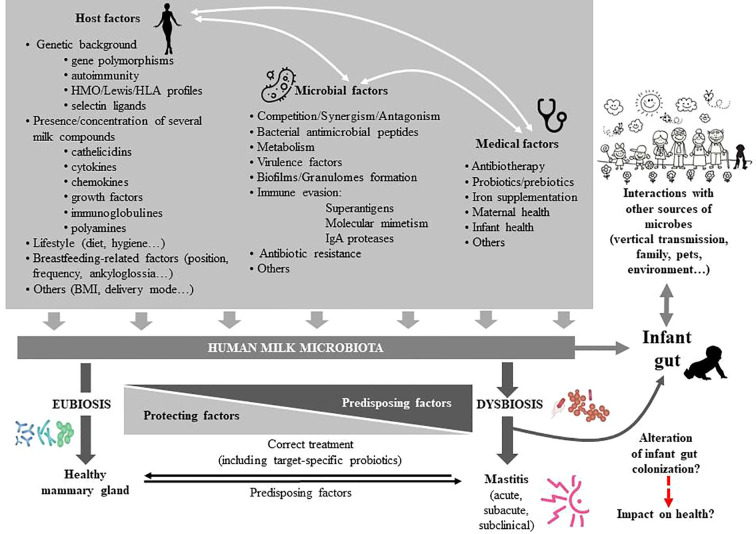
Factors affecting the composition of the human milk microbiota. HMO, human milk oligosaccharides; HLA, human leukocyte antigen; BMI, body mass index; IgA, immunoglobulin A.